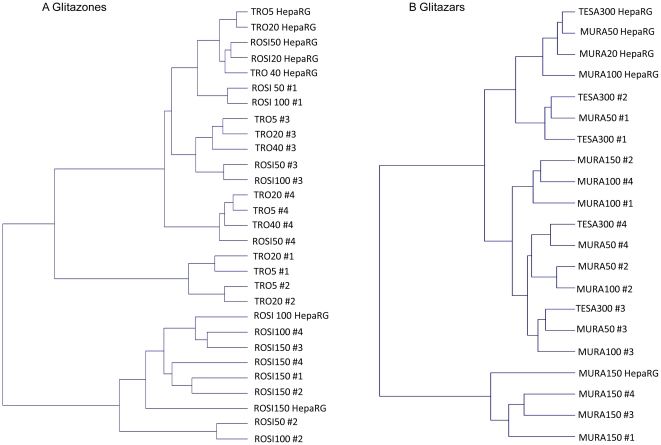
Two-dimensional hierarchical clustering of gene expression profiles in hepatocytes treated with PPAR agonists.The clustering was generated by using Resolver system software with an agglomerative algorithm Ward's min variance link heuristic criteria and Euclidean distance metric (FC≥1.5 and p≤0.01). Two-dimensional clustering was performed on gene expression profiles in hepatocytes treated with glitazones (a) and glitazars (b).